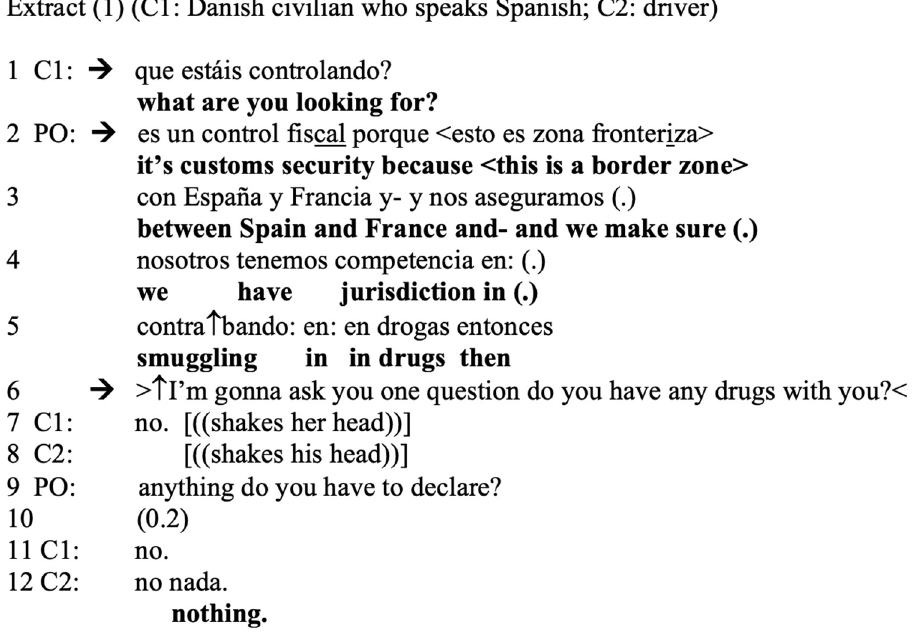
Figure 3. Extract